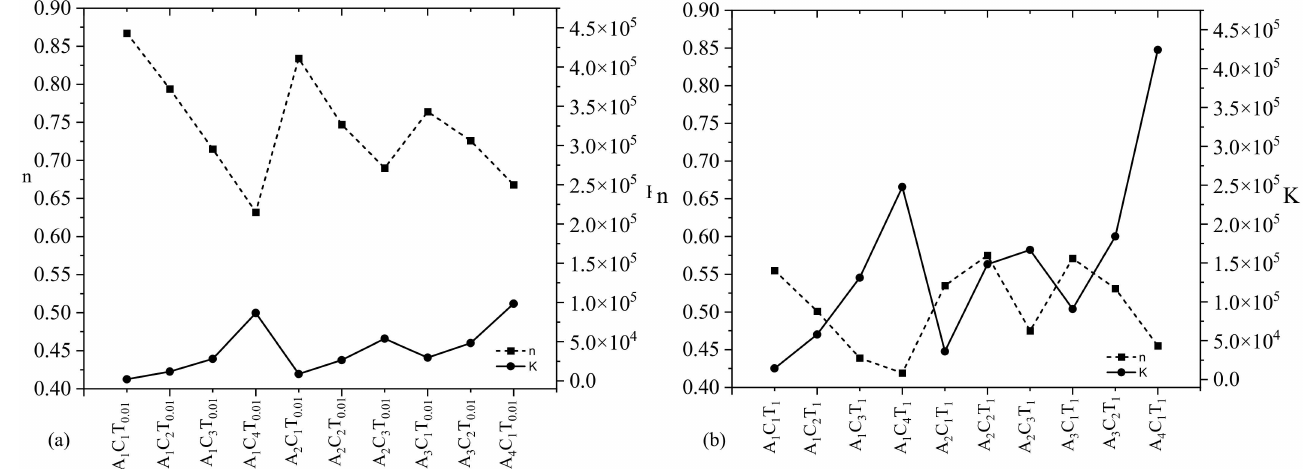
Figure 6. Shear thinning factors ( n and K ) of compositions composed with various percentages of alginate (1–4%) and CMC (1–4%) with a constant percentage ( a ) 0.01% and ( b ) 1.0% of TO-NFC. All n values less than 1 confirm a shear thinning behavior of all